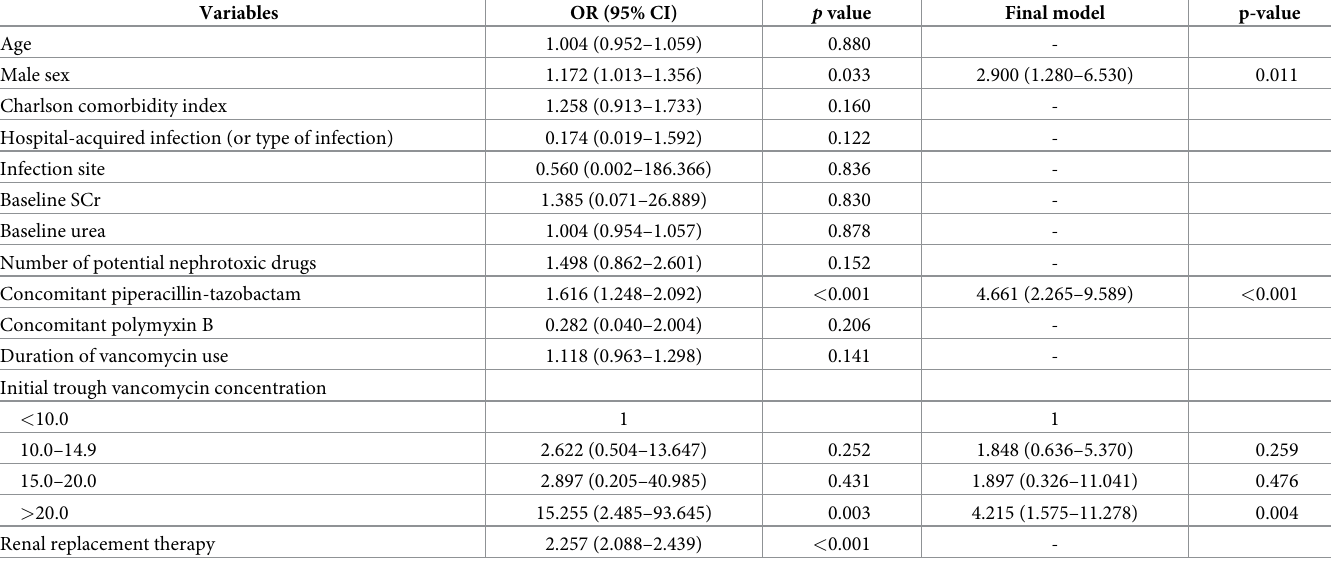
Table 3. Model of regression of Poisson (with robust covariance matrix) for the factors related with acute kidney injury in non-critically patients receiving